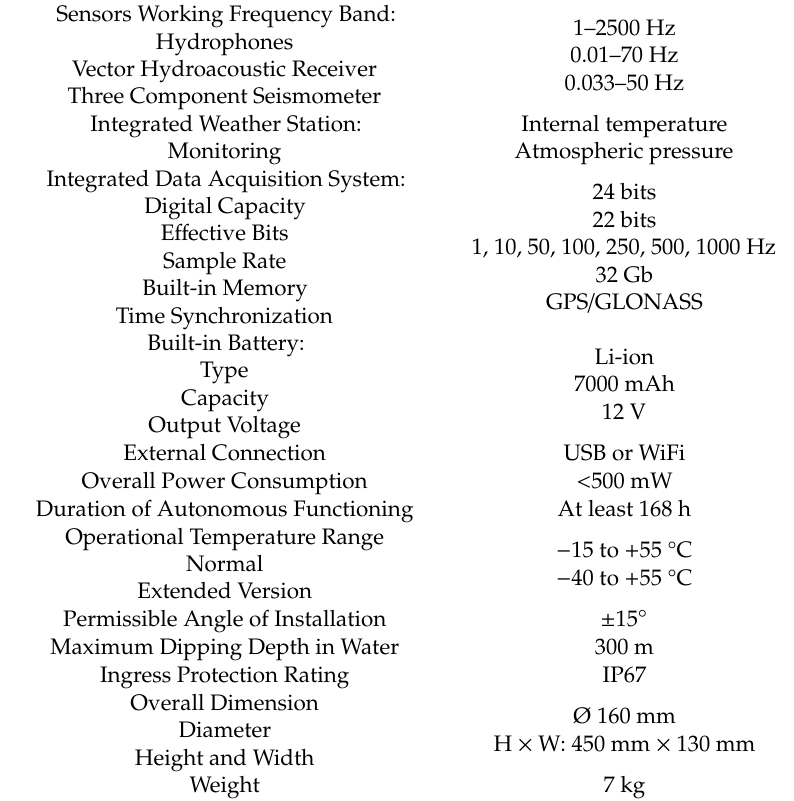
Table 1. Basic parameters of the geohydroacoustic